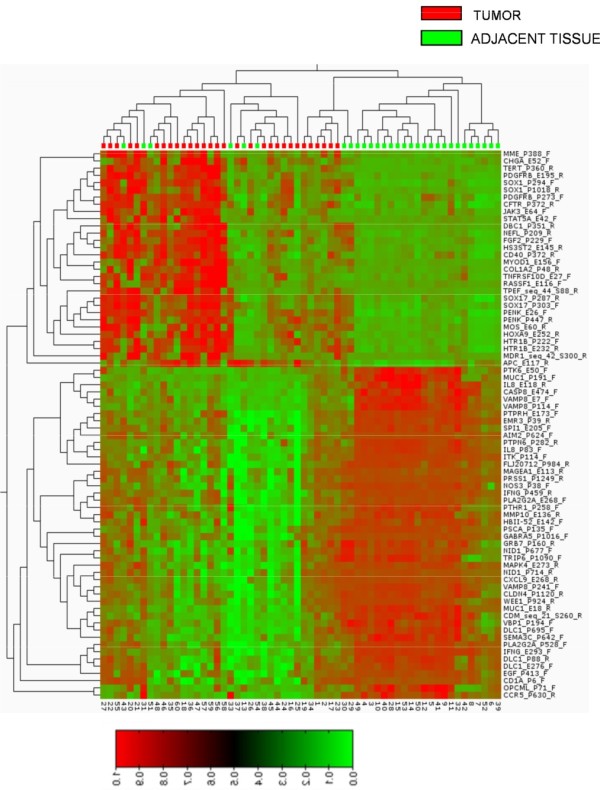
Supervised hierarchic clustering of 28 paired breast cancer samples by using methylation microarray data from differentially methylated genes. Heat map and clustering of 76 significant (FRD-corrected, P < 0.001) differences between tumors (red) compared with adjacent tissues (green) shows that 30 of the differences (corresponding to 25 genes) are increases of methylation, whereas 47 (corresponding to 37 genes) are decreases of promoter methylation in tumors. Heat-map colors symbolize DNA methylation, as indicated in the color key. The full list of genes is presented in Table S2 in Additional file 2.